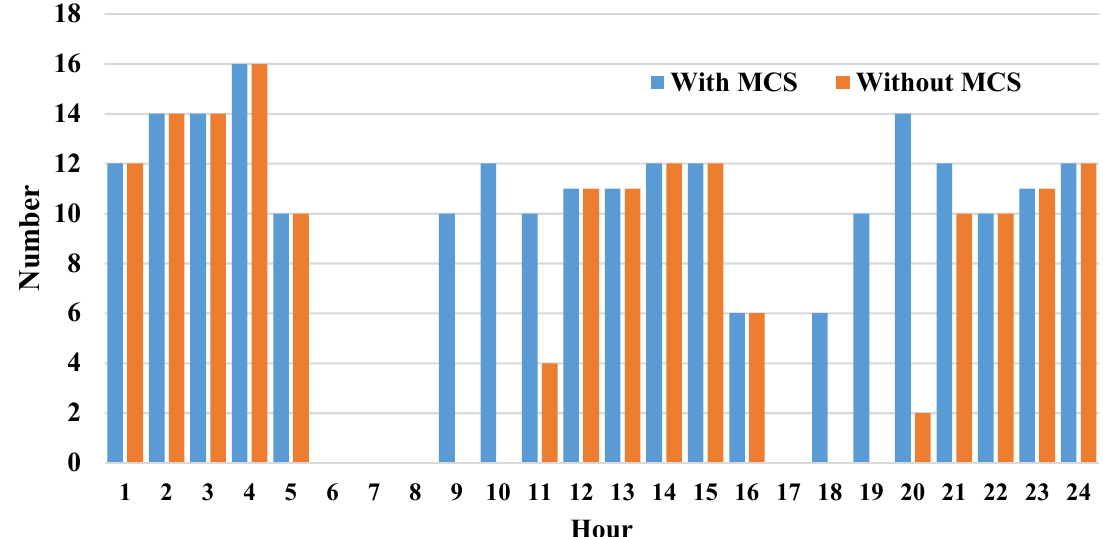
Figure 11. Hourly available empty sockets for charging in the fixed charging station. The hourly power drawn from the grid due to EV charging in the fixed station at bus 31 is depicted in Figure 12. As can be observed, the fixed charging station energy demand has declined over two periods. The first one is related to the first peak EVs charging de- mand, from 8–11 AM. The second period is related to the second and lower peak of the EVs’ charging load during 5–9 PM. The fixed charging station energy demand pattern is entirely in accordance with the MCS behavior discussed previously. In other words, these two periods are in line with the MCS’ battery discharging periods presented in Figure 8 or the stored energy depletion pattern in Figure 9. The reduction in the energy demand of the fixed charging station will, in turn, impact other technical parameters of the network, which is described in the following.